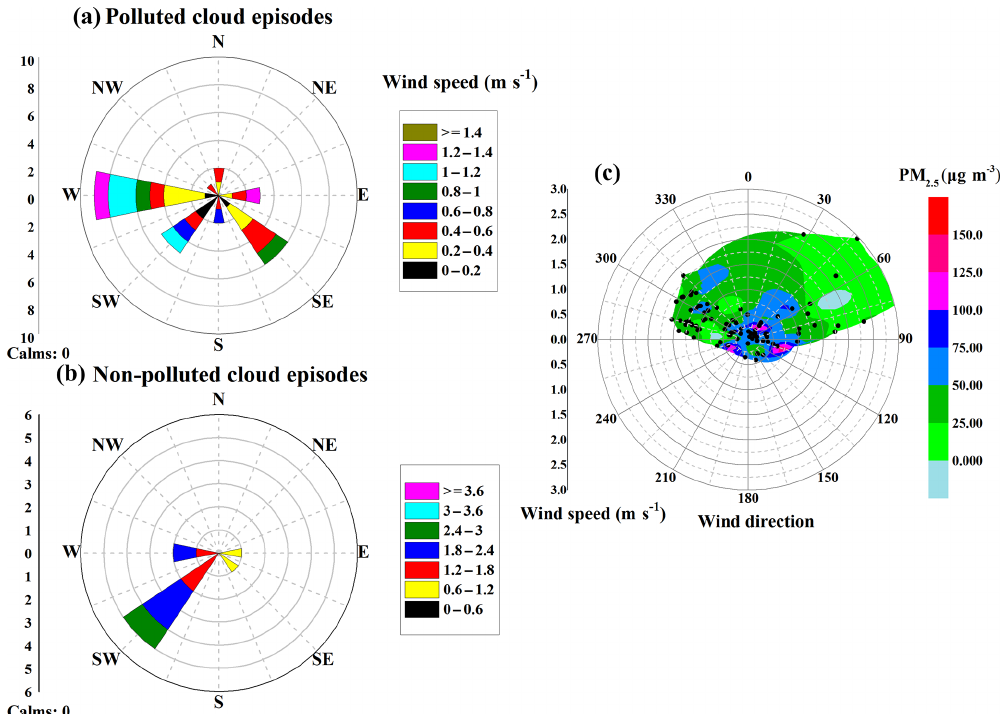
Figure 7. Wind rose diagram to quantitative analyze wind speed and wind direction during sampling time between polluted (a) and non- polluted (b) cloud episodes. The frequency of winds is indicated by wind direction. Wind speed range is labeled with color bands. Wind direction with the greatest frequency is shown by the direction of the longest spoke. Panel (c) shows distribution of wind speed during the whole sampling time (from 24 July to 23 August 2014) and the correlation with PM 2 . 5 concentration. As shown in the figure, PM 2 . 5 concentration was high under lower wind speed, whereas PM 2 . 5 was lower when wind speed was